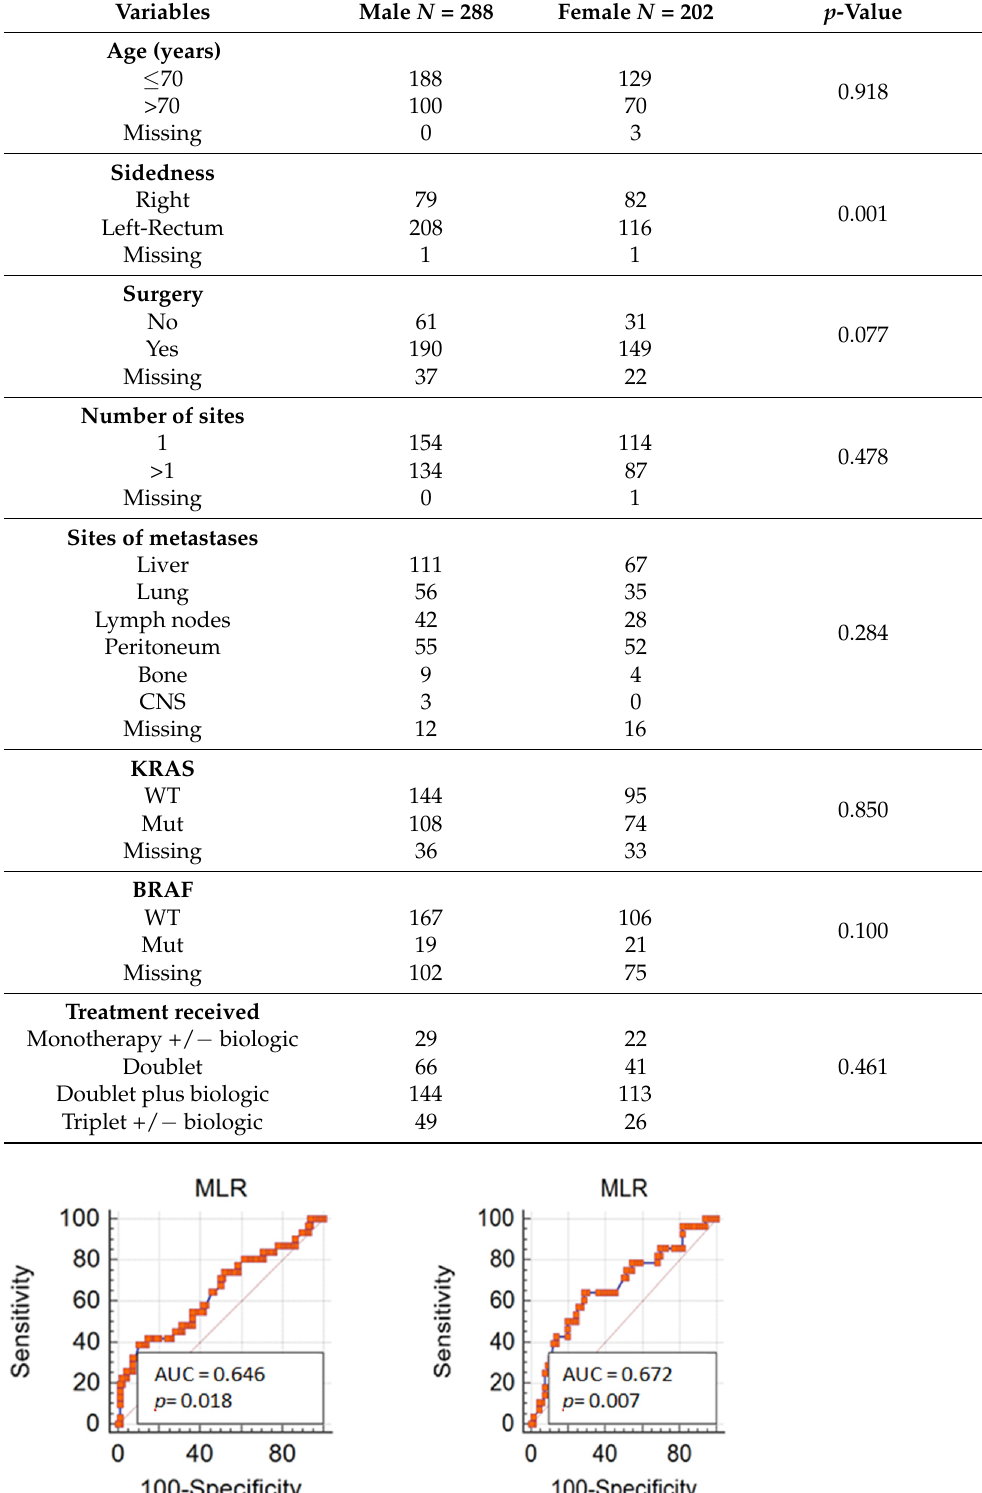
Table 2. Patient’s characteristics according to gender.